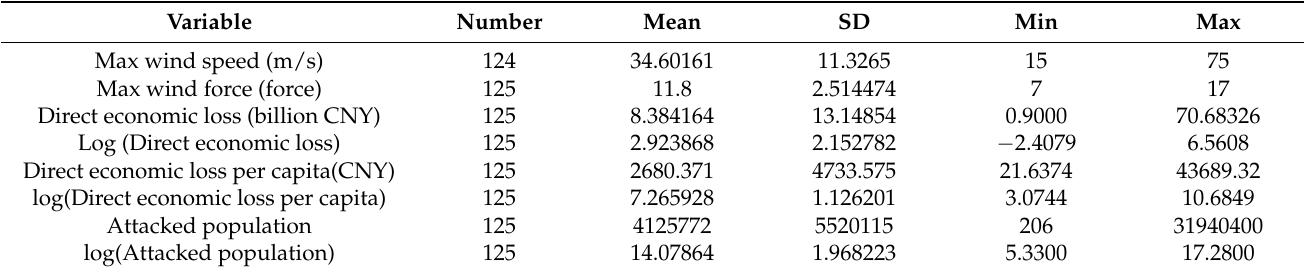
Table 2. Descriptive statistical analysis of the